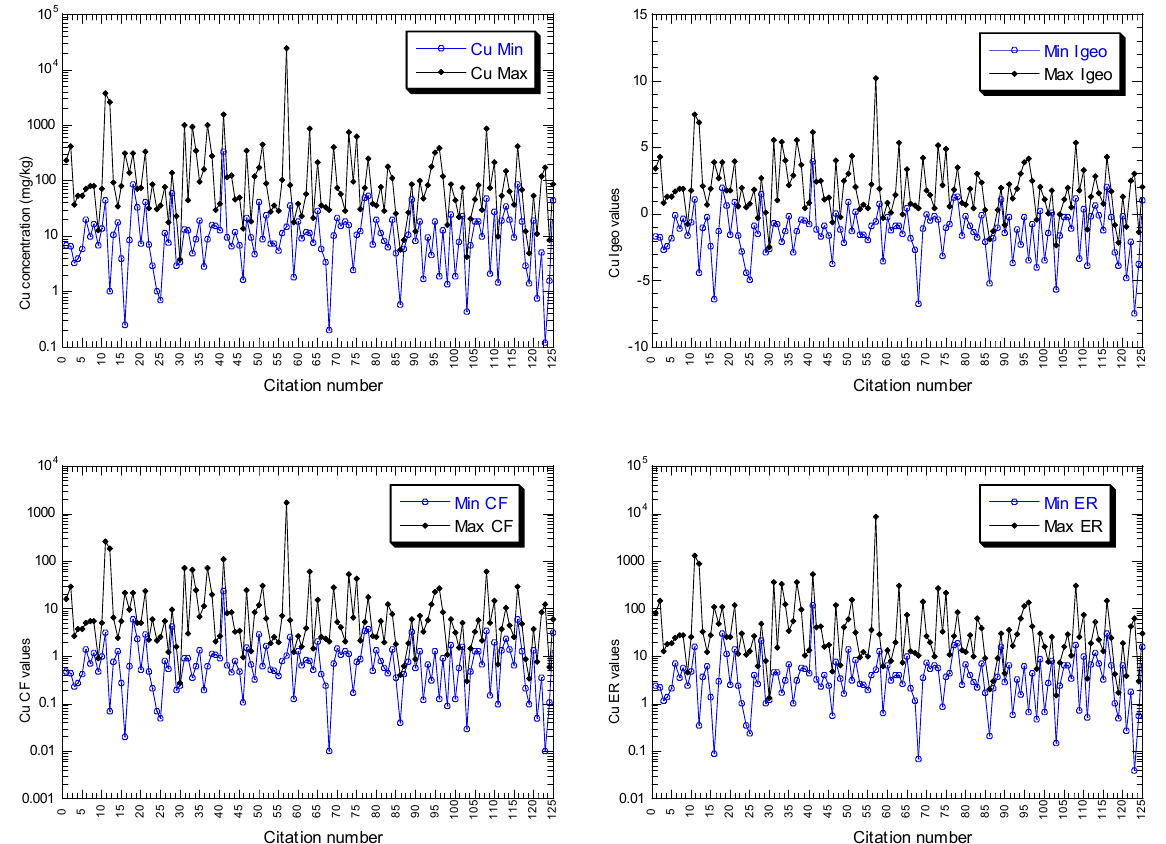
Figure 3. The calculated values of the geoaccumulation index (I geo ), contamination factor (CF), and ecological risk (ER), based on the Cu concentration ranges (mg/kg dry weight) (minimum and maximum) in the sediments cited from 125 papers in the literature published between 1980 and 2022. The citation numbers follow the detailed reference numbers presented in Tables S1 and